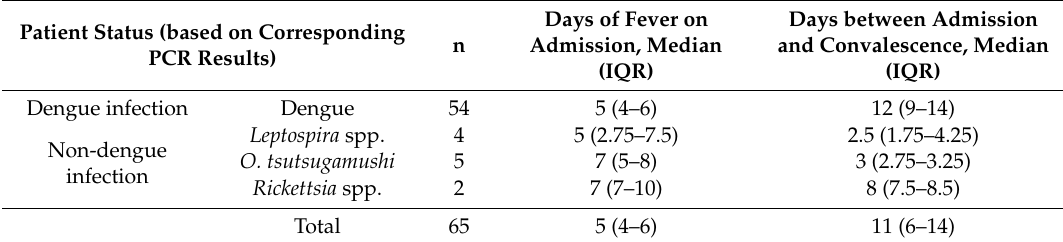
Table 1. Summary of dengue suspected patients’ samples in Panel A (infection status by PCRs’ results, number, fever days, interval between admission and